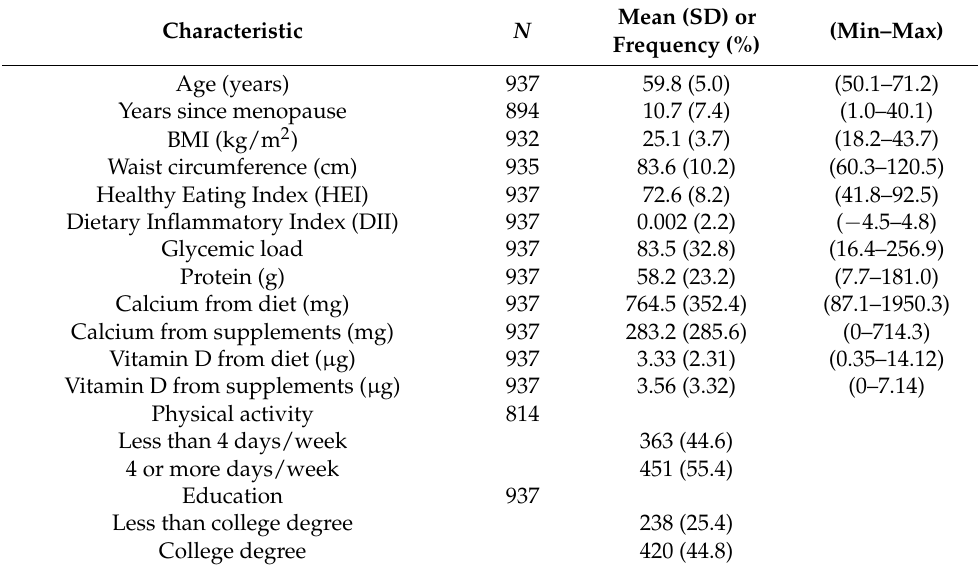
Table 1. Selected characteristics of postmenopausal women who participated in the Minnesota Green Tea